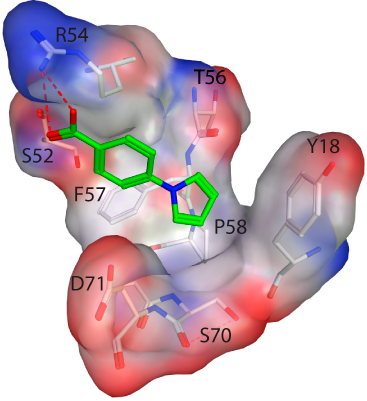
Figure 10. Second ranking pose after CSP and STD filter. The protein surface defining the binding site is rendered with atom color.